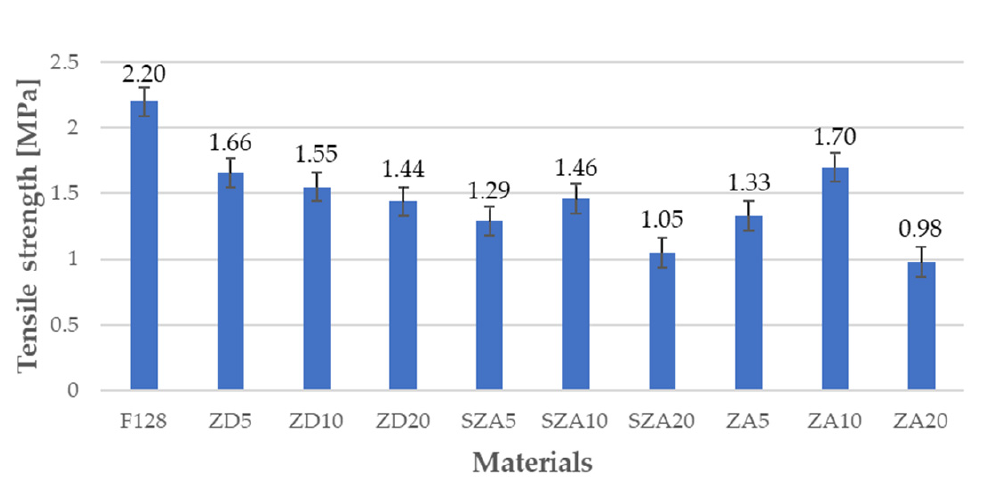
Figure 6. Tensile strength of the tested materials.